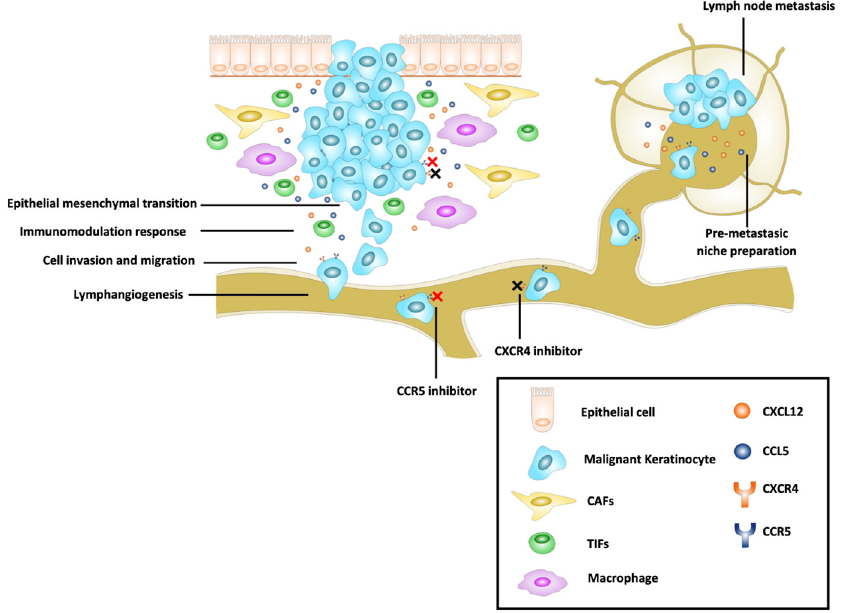
Figure 2. Schematic representation of oncogenic mechanisms mediated by the CCR5/CCL5 and the CXCR4/CXCL12 axes in carcinomas. The primary local sources of CCL5 and CXCL12 are CAFs, TILs, cells, macrophages, and tumor cells, while in lymph nodes, the primary sources are lymphatic fibroblasts, endothelial cells, lymphocytes, and tumor cells. These axes have a role in early events, such as epithelial–mesenchymal transition, local immune response modulation, local cell invasion, migration, and lymphangiogenesis, and in late events, such as premetastatic niche preparation, migration to lymph nodes (oncochemotaxis), and lymph node metastasis.